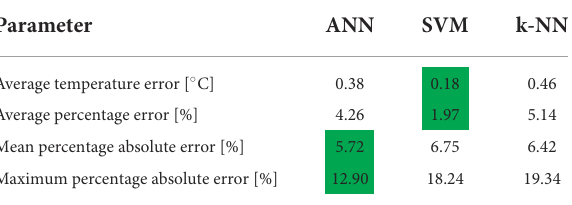
TABLE 4 Accuracy comparison of predictive